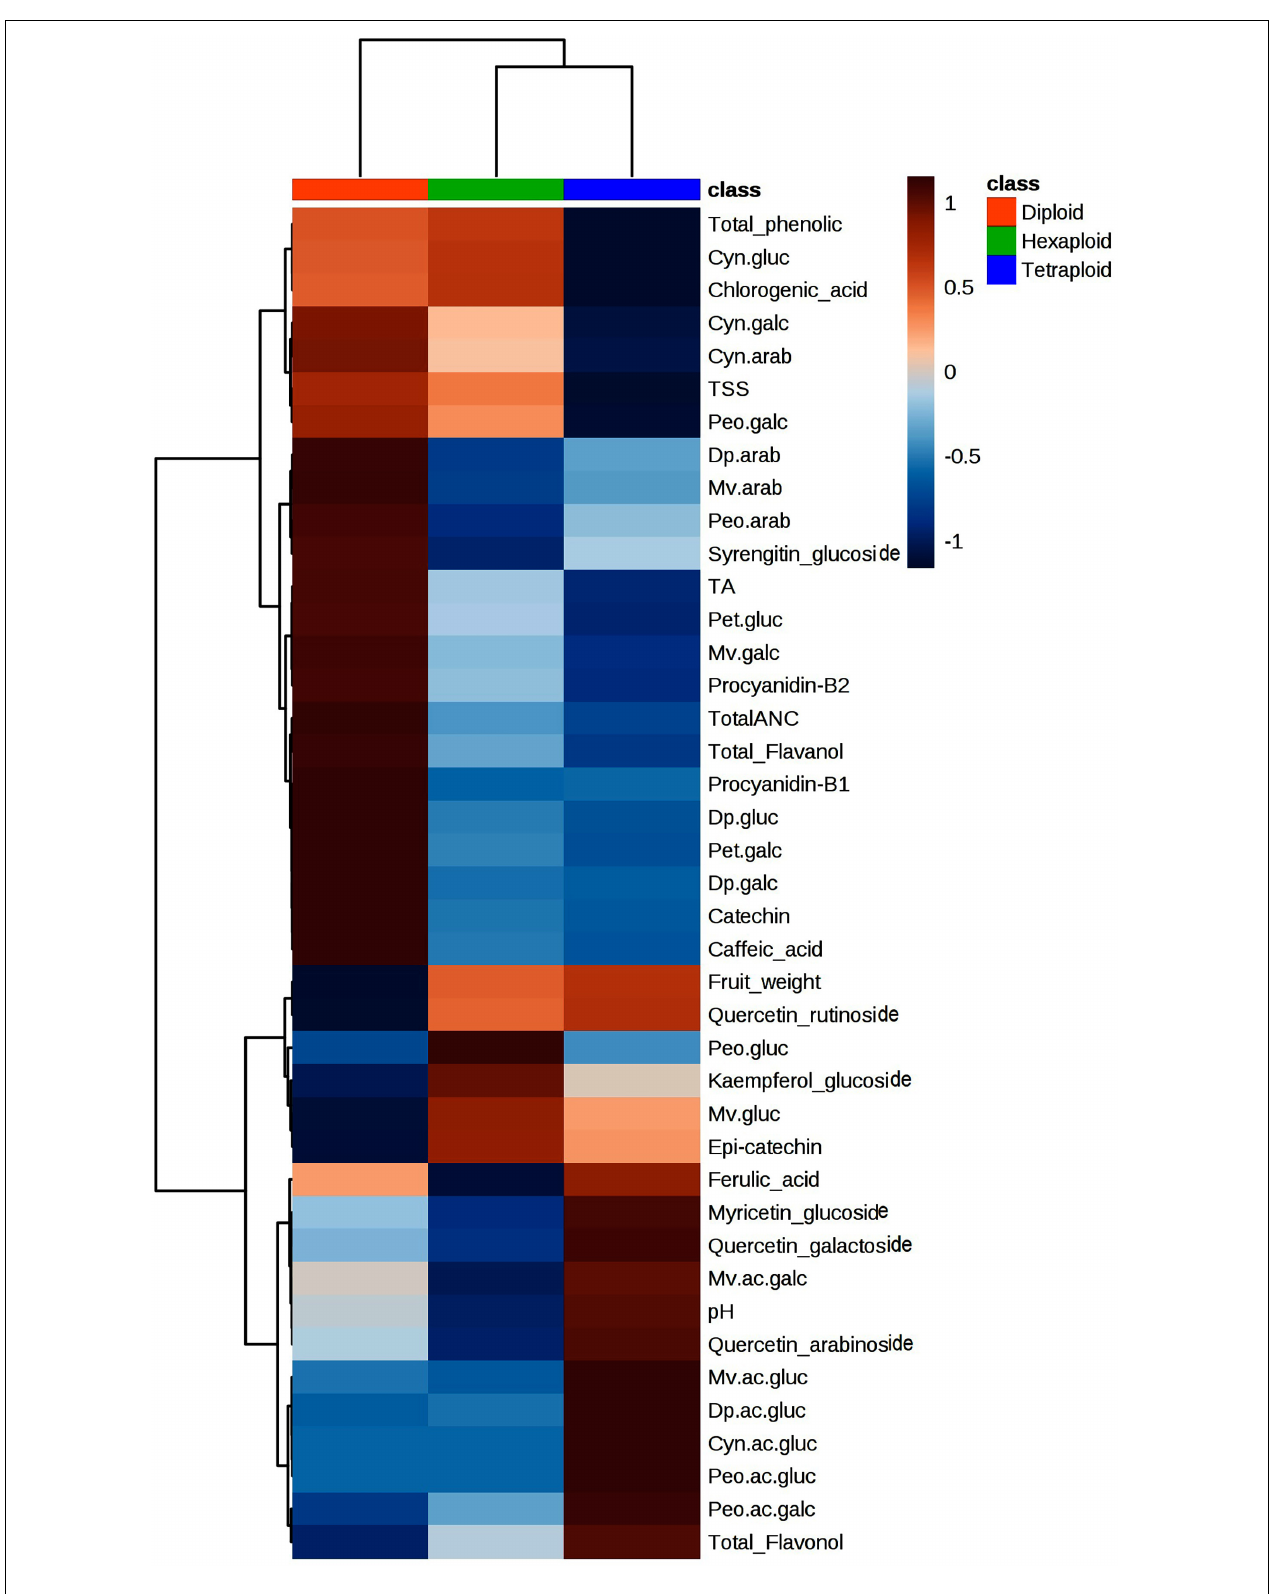
FIGURE 7 | Heatmap showing variation of metabolites and fruit quality traits across the three-ploidy levels. Red and blue colors indicate highest and lowest performance of the traits, respectively.